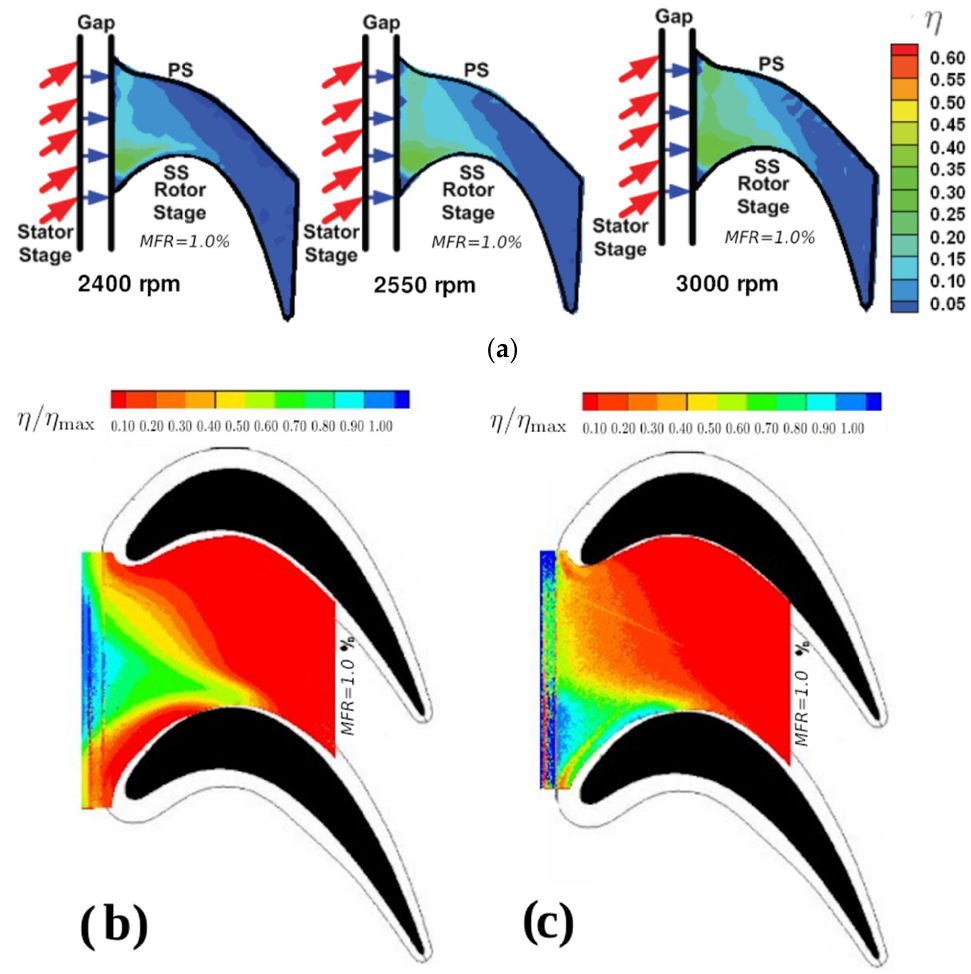
Figure 7. Comparison between stage and cascade results at MFR = 1%: ( a ) three different rotational tests [29] ( b ) static test without fins [23] and ( c ) static test with simulated rotational effects by inclined fins ( − 10°) [23].